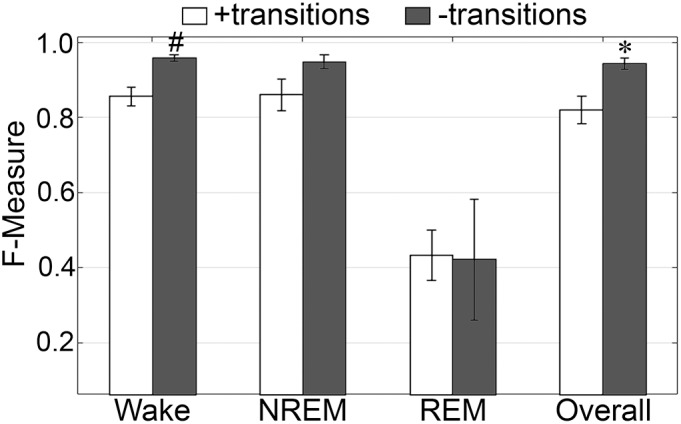
Impact of transition epochs on generalization of pigeon recordings. Generalization of all pigeon recordings (n = 5), with and without consideration of transition epochs. Data analyzed by paired t-test compared to training with all epochs, and represented as mean ± SEM. ∗p < 0.05; #p < 0.01.